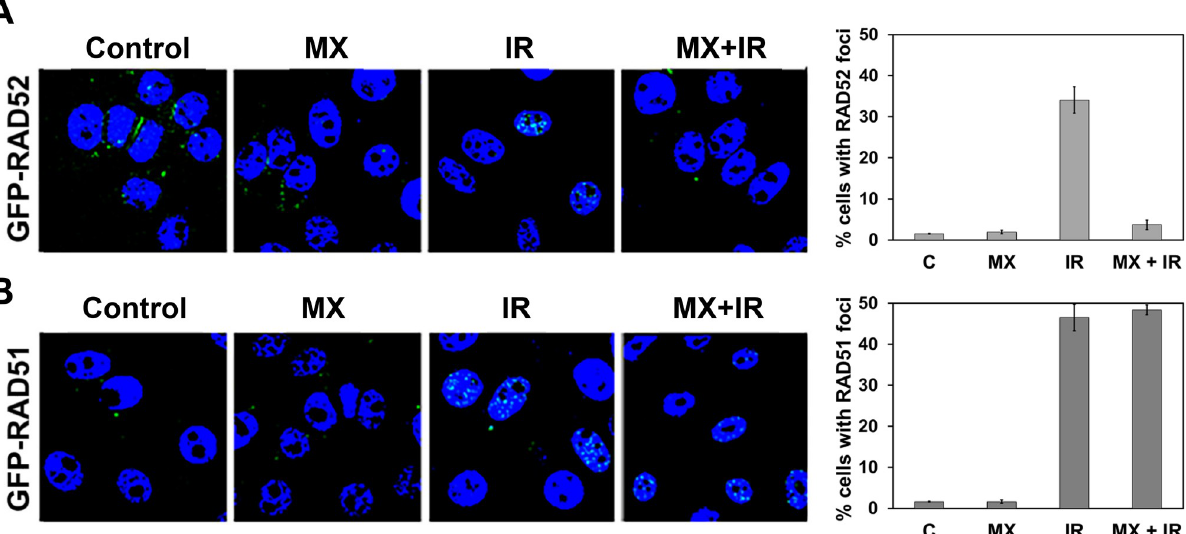
Fig 8. Effect of RAD52 inhibitor mitoxantrone on radiation-induced GFP-RAD52 and GFP-RAD51 foci formation in the HR-proficient ovarian cancer cells. PE01 C4-2 cells constitutively expressing (A) GFP-RAD52 and (B) GFP-RAD51 were treated with mitoxantrone (MX, 3 nM) alone, radiation alone (IR, 15 Gy, RAD Source RS2000) or both. Cells without mitoxantrone and radiation (labeled C) were controls. The average percent of cells with foci (more than 5 foci per cell) are graphed from three independent experiments. More than 30 cells per experiment were analyzed. Error bars represent standard deviation. GFP-RAD52 and GFP-RAD51 were stably expressed individually in PE01 C4-2 (S5 Fig).